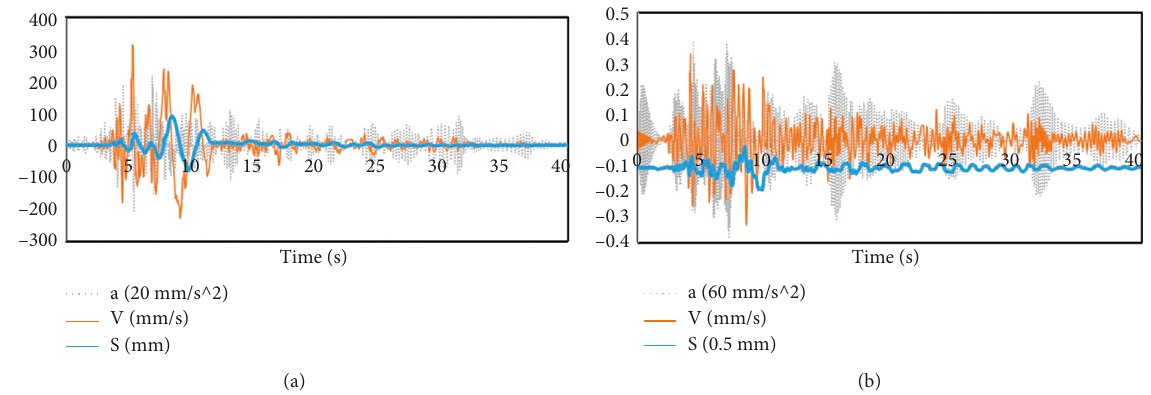
Figure 53: Time course curves of bearing deformation displacement, velocity and acceleration when N90 is input from X direction. (a) Horizontal deformation. (b) Vertical